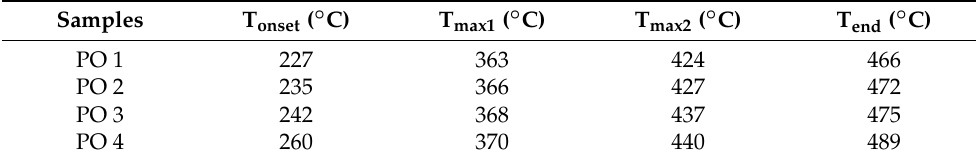
Table 12. Thermal degradation temperature of MREs with different ratios of PO:AO.